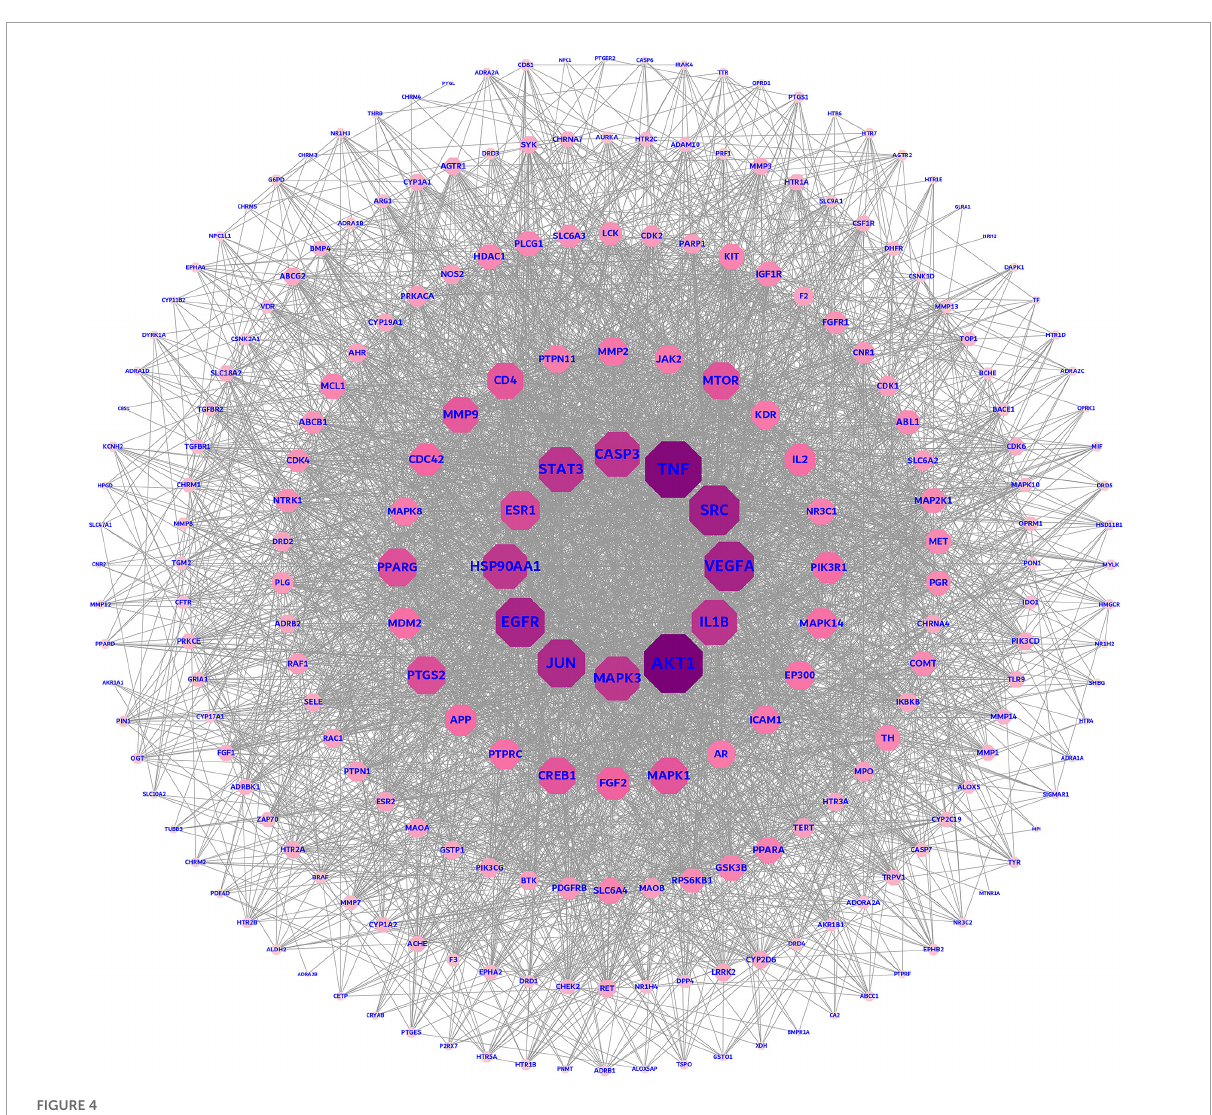
FIGURE4 Protein-protein interaction (PPI) network